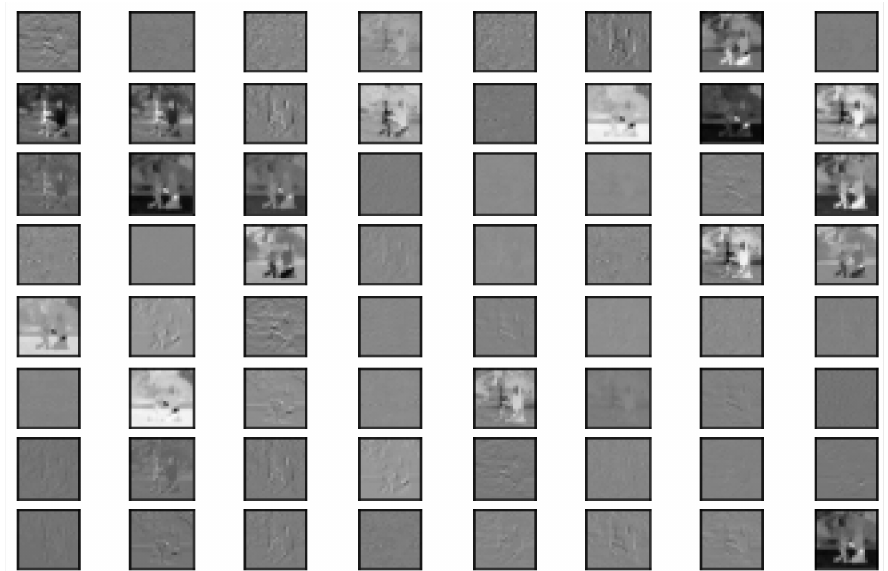
Figure 14. Feature map from Dense_Block1 of the DenseNet-121 model.